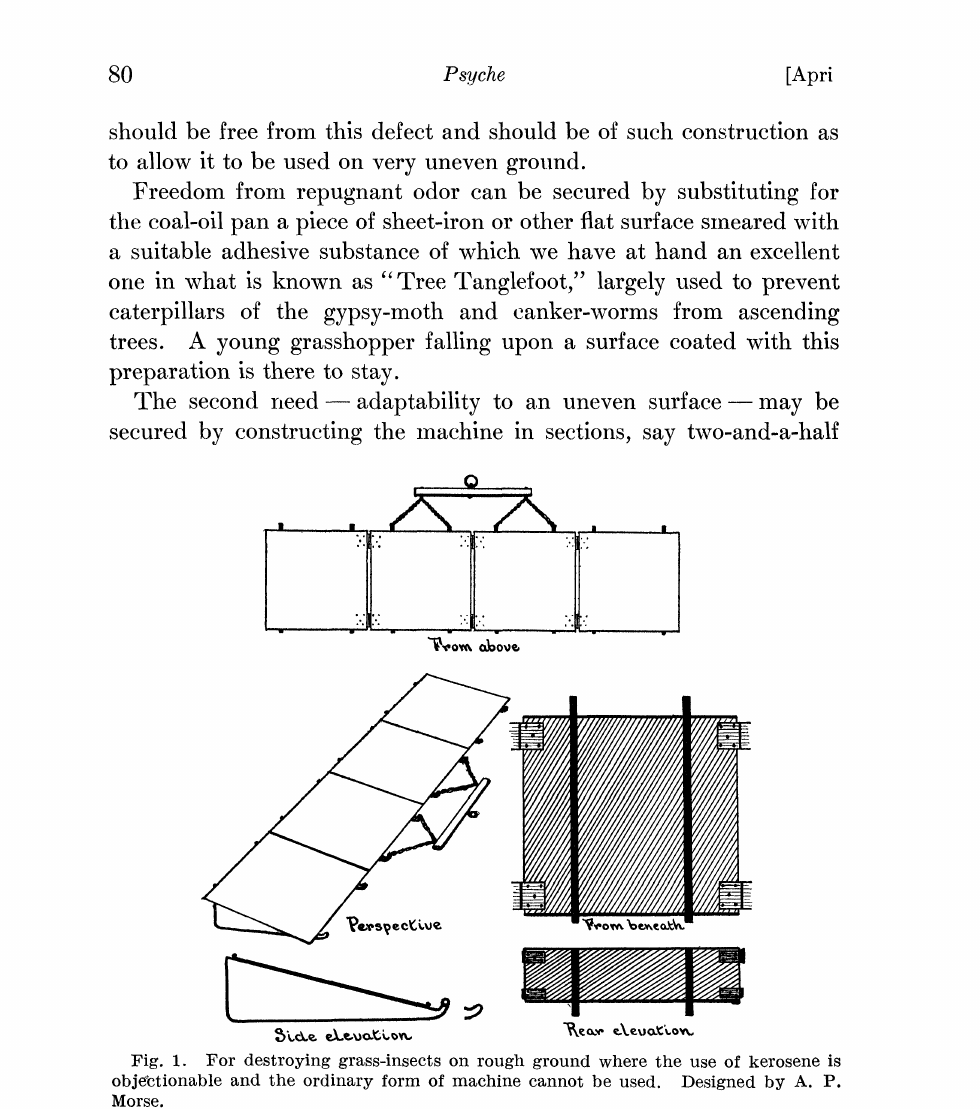
:Fig. 1. :For destroying grass-insects on rough ground where the use of kerosene is objectionable and the ordinary form of machine cannot be used. Designed by A. P.